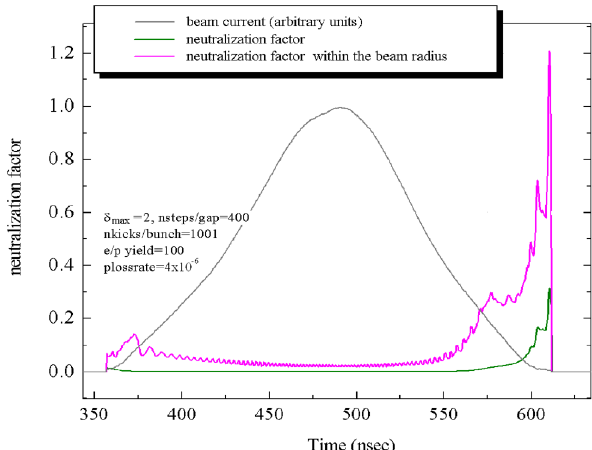
FIG. 10. (Color) Simulated electron neutralization factor in a PSR field-free region. The fractional charge neutralization computed within the beam radius region is 2% during the bunch passage, and it exceeds 20% at the tail of the